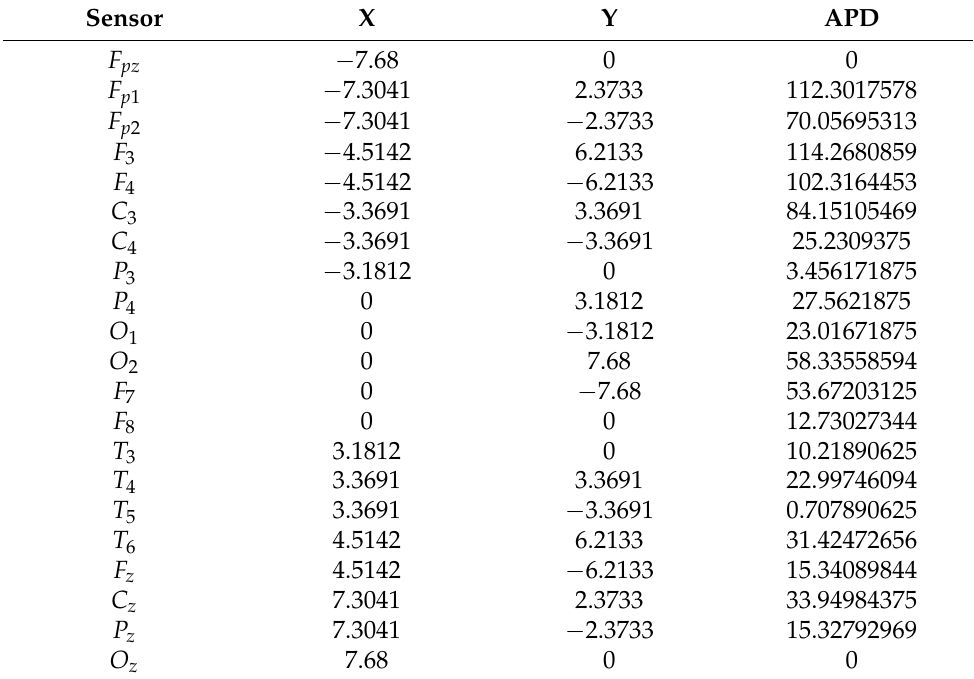
Table 5. Reordering APD at the sensor at t = 2 of patient A [14].